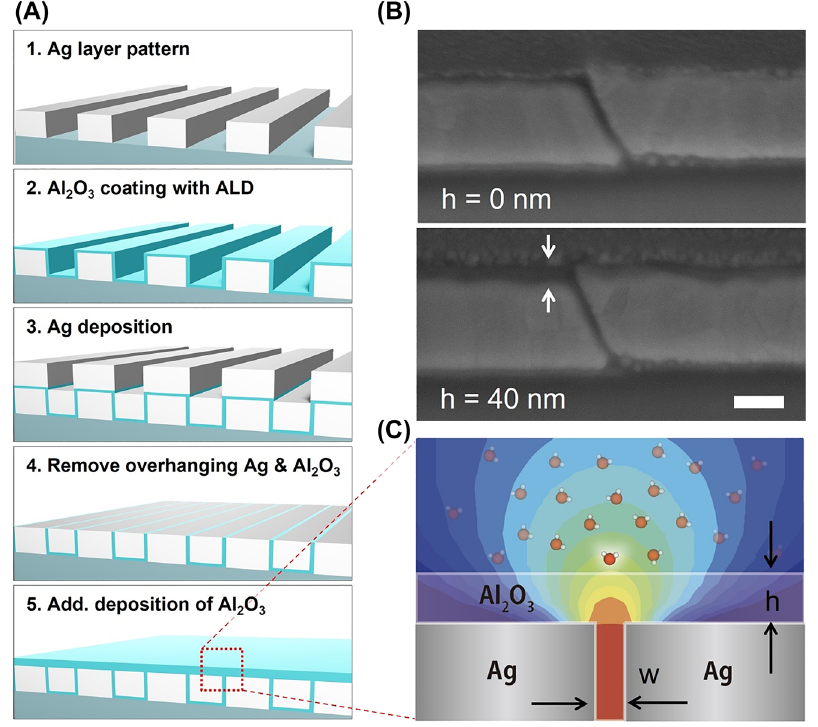
Figure 2: Nanometric control of distance between the nanotrenches and water molecules. (A) Fabrication process for the nanotrenches. On an Ag layer patterned by photolithography and lift-off, alumina is conformally coated on the whole structure with atomic layer deposition (ALD) technique (step 1, 2). Subsequent deposition of additional Ag fills the void, and Ag–alumina–Ag gaps are formed at the sidewalls with gap widths equal to the thickness of deposited alumina (step 3). Mechanical exfoliation and subsequent angled dry etching cleans up the surface (step 4), and distance from the gap is controlled with additional deposition of alumina with ALD (step 5). (B) Cross-sectional scanning electron microscope image of a 10 nm wide gap sample before (top) and after (bottom) deposition of 40 nm alumina on top. (C) Schematic figure showing absorption enhancement for water molecules outside the hot spots of the